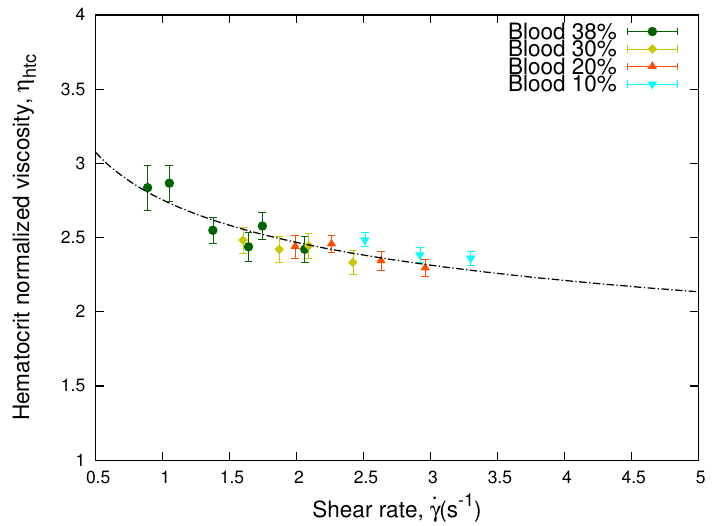
Figure 4. Hematocrit normalized viscosity vs. shear rate. The figure shows the hematocrit normalized viscosity, η htc , of the same blood sample as a function of the shear rate. The curves were collapsed onto a single curve according to Equation (15) using φ control = 0.38. The line represent the fit obtained through Equation (2) for the hematocrit normalized viscosity. The value of the parameters are m = 2.75 and n =